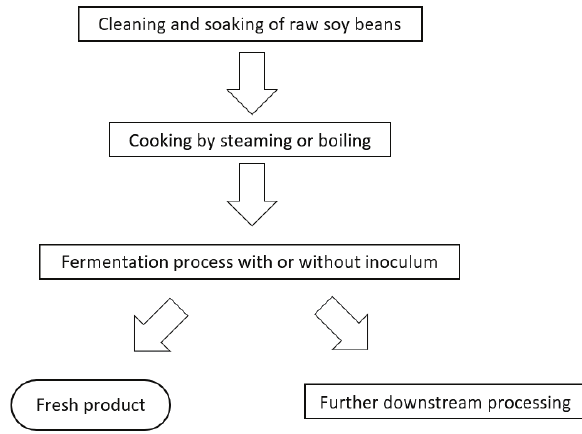
Figure 3: The typical production process of fermented soybean (FSB)